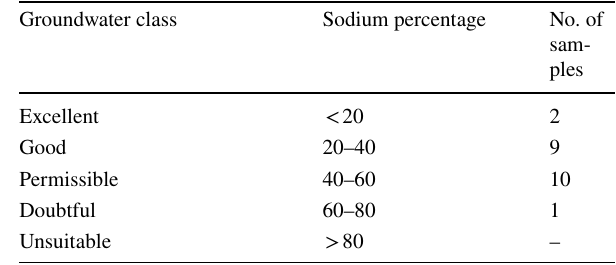
Table 7 Classification of irrigation water based on sodium percentage (Wilcox